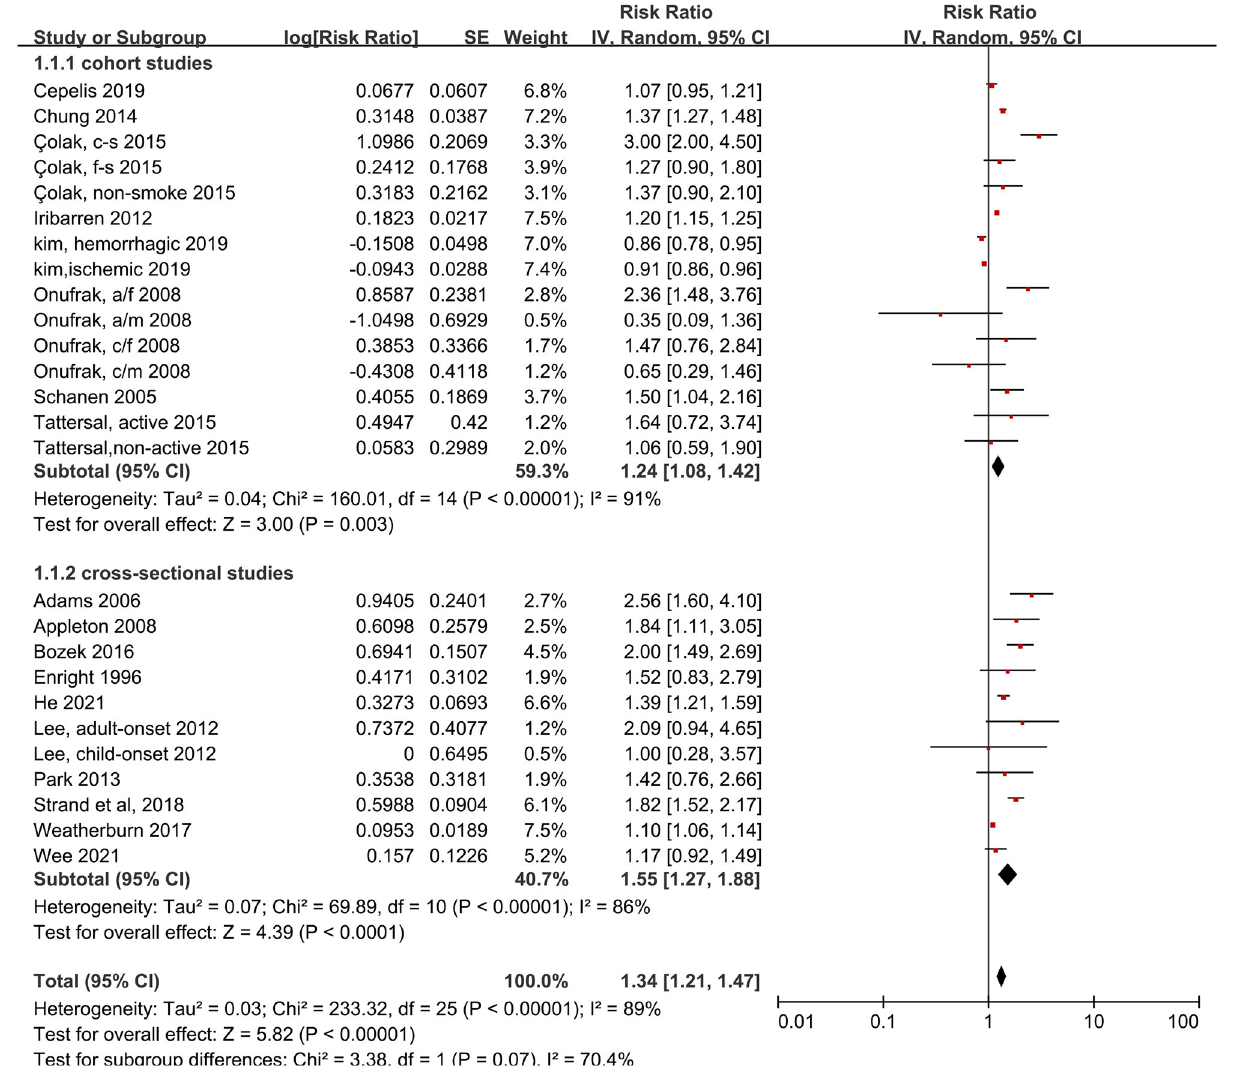
FIGURE 2 | Forest plot shows association between asthma and risk of stroke. SE, standard error; IV, Inverse Variance method; df, degrees of freedom; CI, confidential interval; a/f, adult female; a/m, adult male; c/f, child female; c/m, child male; c-s, current smoking; f-s, former smoking; n-s, never